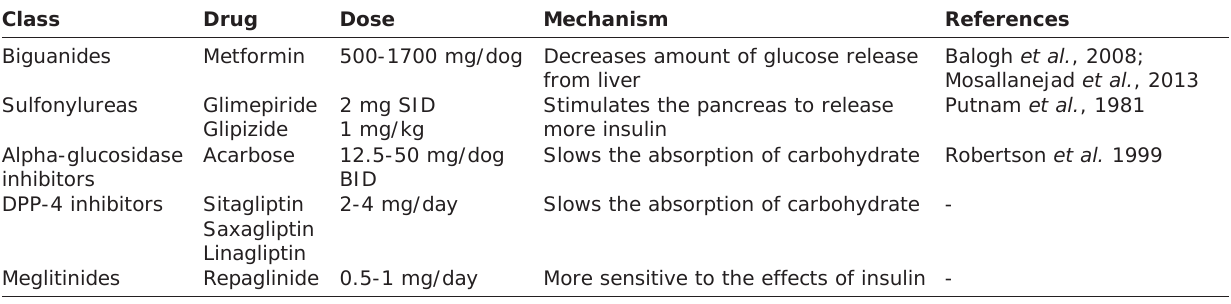
Table-1: Oral drugs available for use in